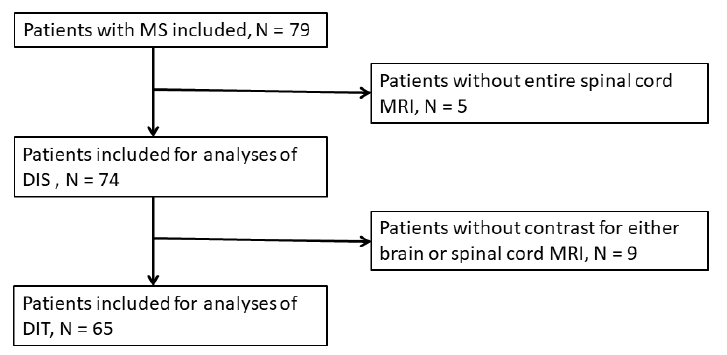
Figure 1. Study Figure 1. Study flowchart.